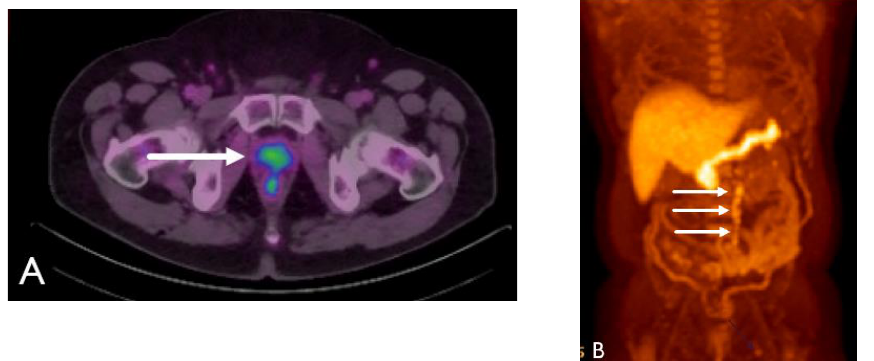
Figure 7. Fifty-six-year-old male with prostate cancer, status post-combination radiation and hormone therapy, now presenting with rising PSA. ( A ) Axumin-fused PET/CT image shows Axumin uptake within the prostate gland (arrow) concerning for local recurrence. MIP image ( B ) shows Axumin uptake within a chain of left peri-aortic lymph nodes (arrows) extending to the level of the